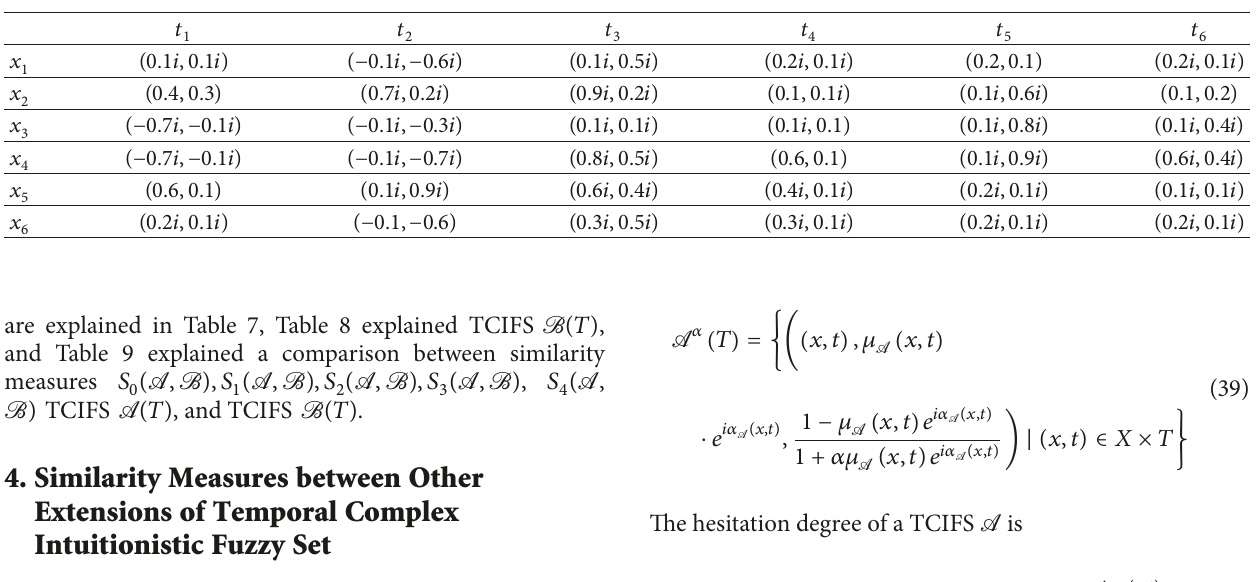
Table 8: TCIFS B (𝑇)